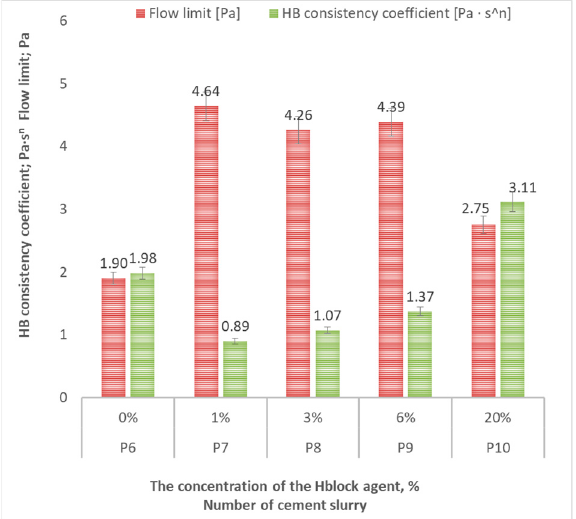
Figure 15. Summary of selected test results for rheological parameters of cement slurries (cement class CEM G).